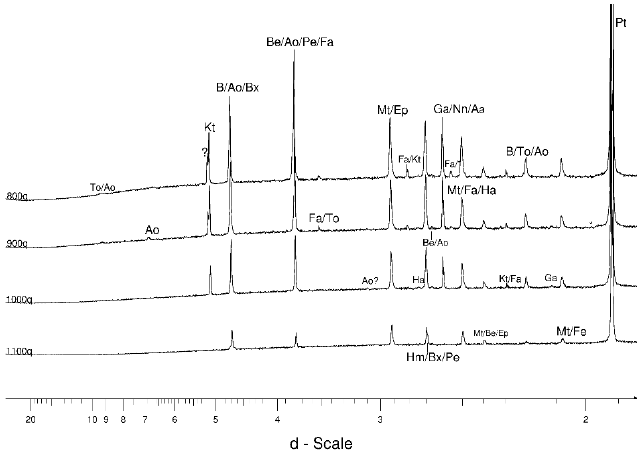
Figure 5. Results of cooling (q) of the LSCB sideritic sample over the 1100–800 °C range. Aa—alabandite, Ao—akatoreite, Ga—garnet supergroup, Ha—hausmannite, Nn—niningerite, Pe—perovskite, To—Ti 3 O 5 phase. Other symbols and explanations s in Figures 1–4. Minerals 2020 , 10 , 586